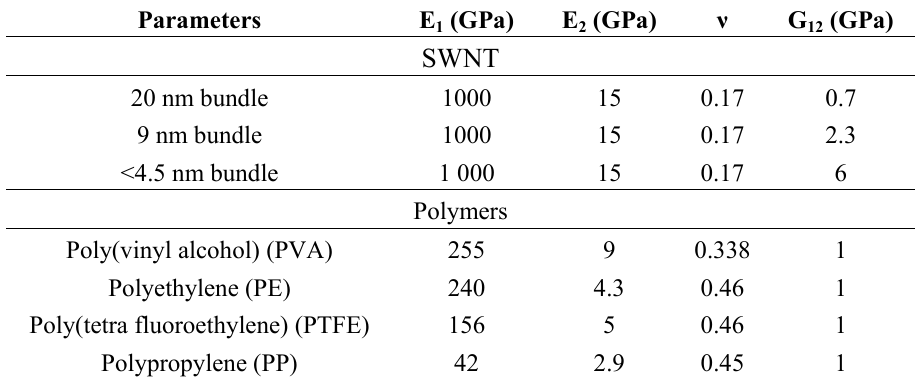
Table 3. List of parameters used for Equations (6) and (7) for orientation analyses corresponding to the Young’s modulus contribution along the axial direction